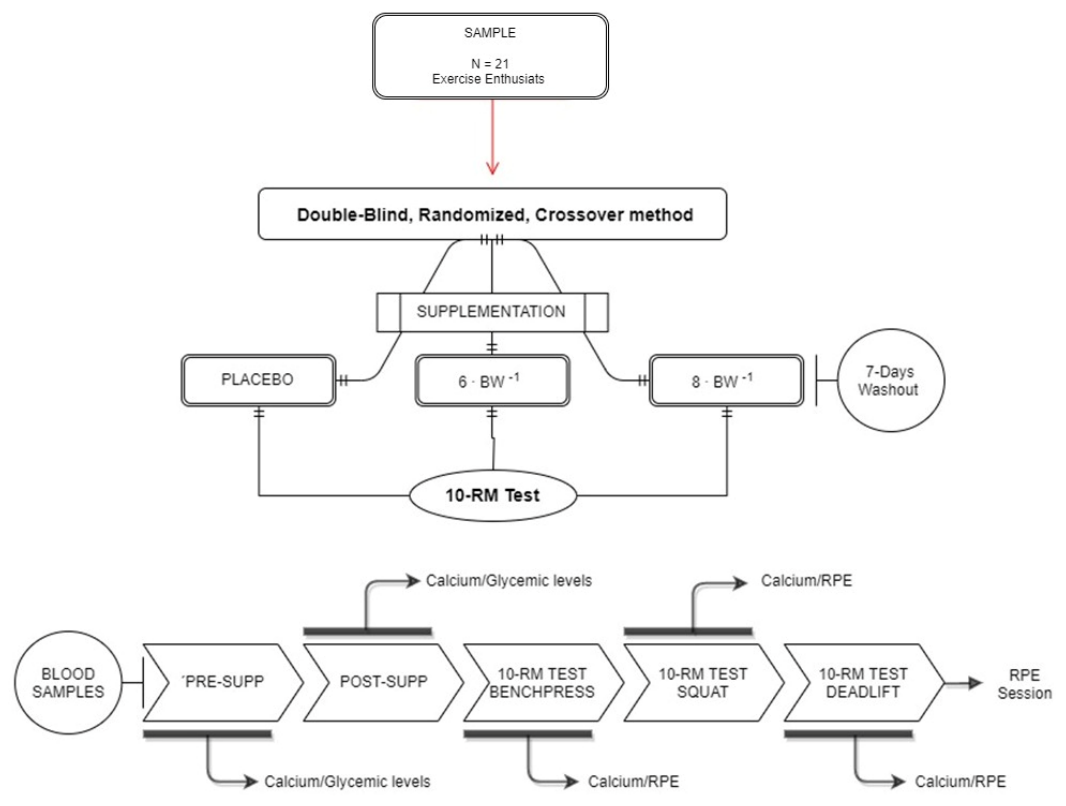
Figure 1. Study Design.